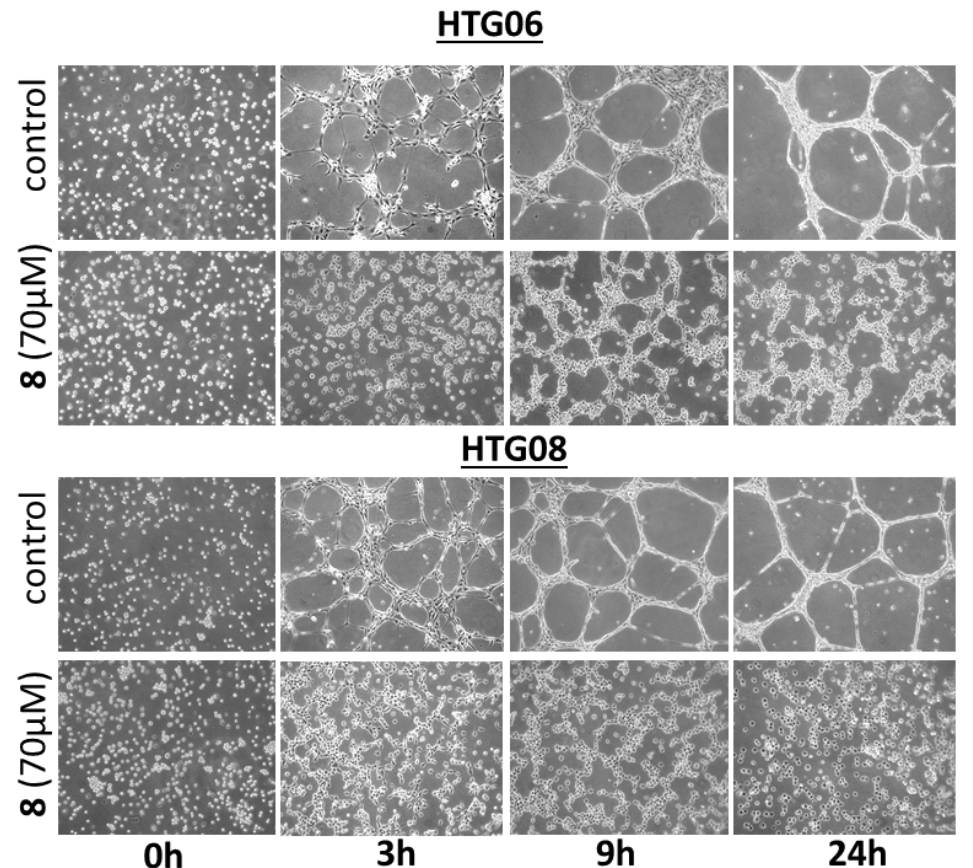
Figure 4. Representative images of the tubular network formation of HUVEC endothelial cells when cultured on Matrigel over a 24 h period. Two distinct HUVECs primary cultures, HTG06 and HTG08, were used. Treatment with DBHB ( 8 ) at 70 µM completely impaired the ability of endothelial cells to form these